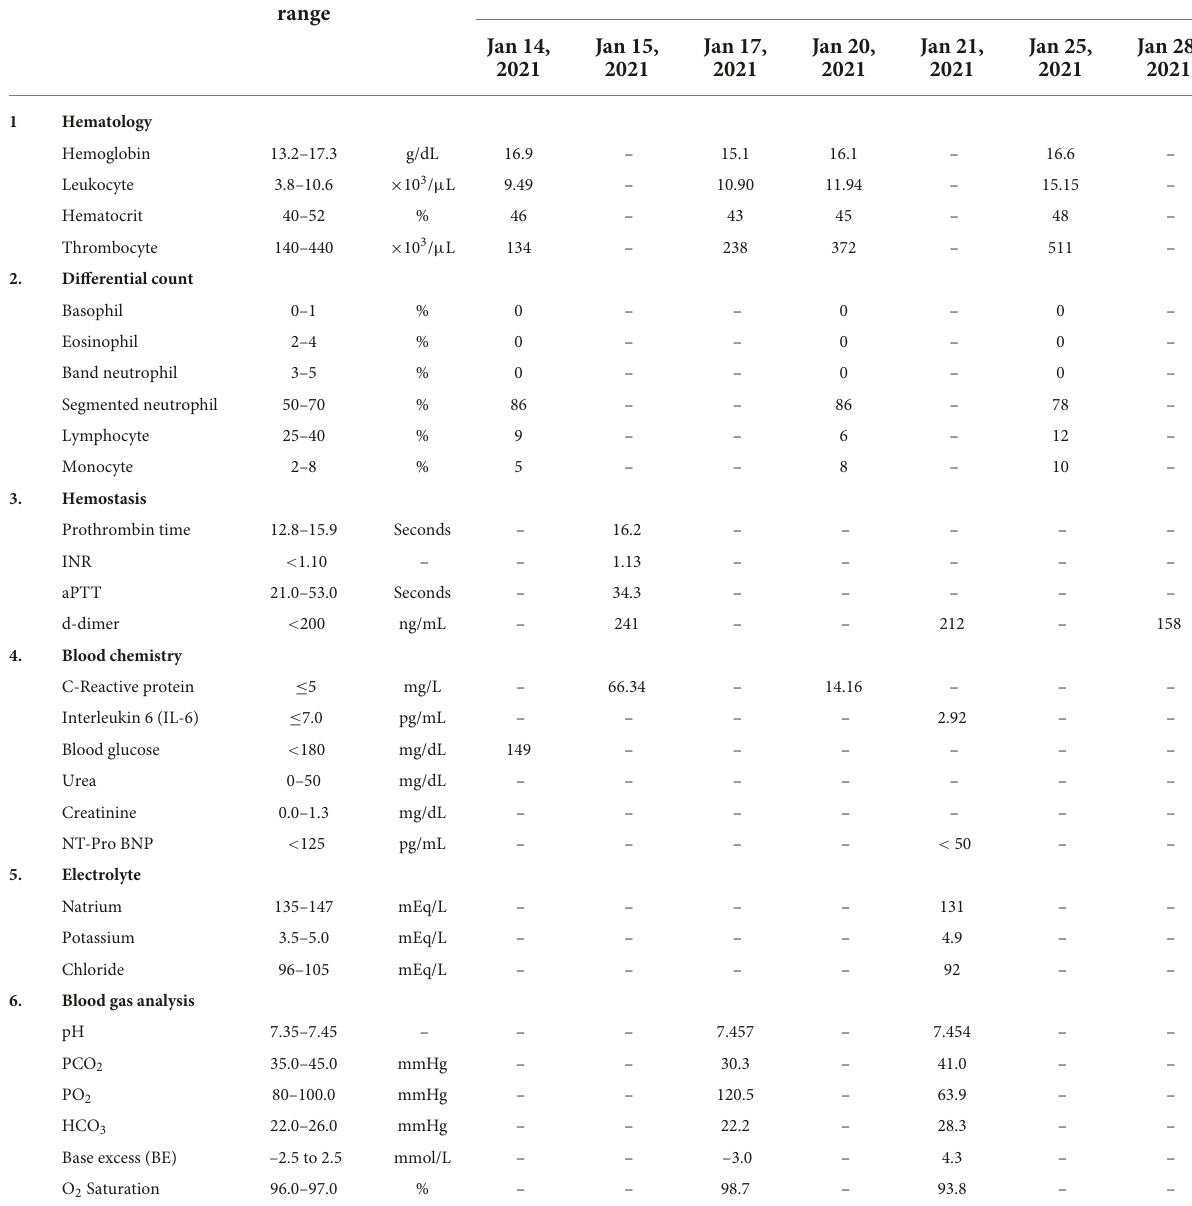
TABLE 1 Blood laboratory testing during infection episode